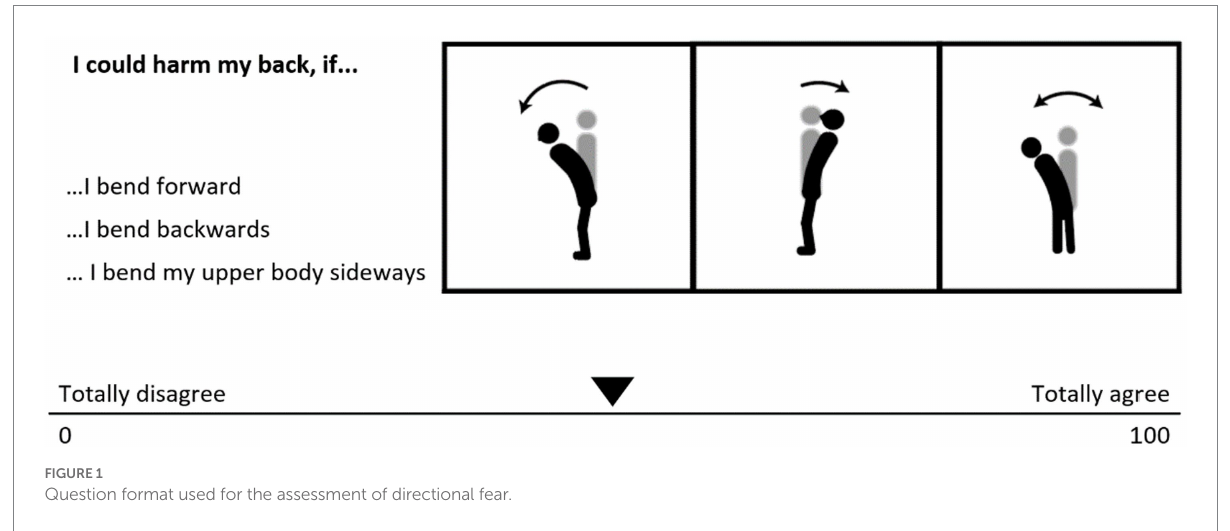
FIGURE 1 Question format used for the assessment of directional